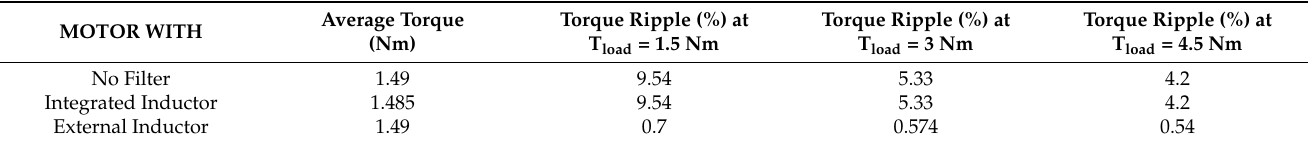
Table 2. Torque Ripple of Motor with Integrated and External Inductor.